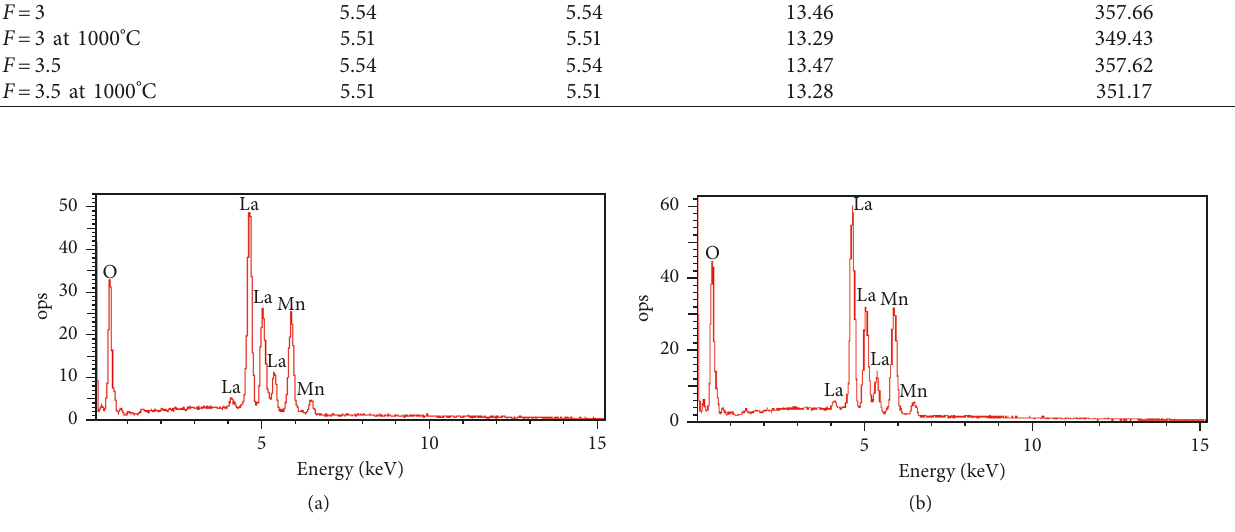
Figure 3: EDS spectra of the LaMnO